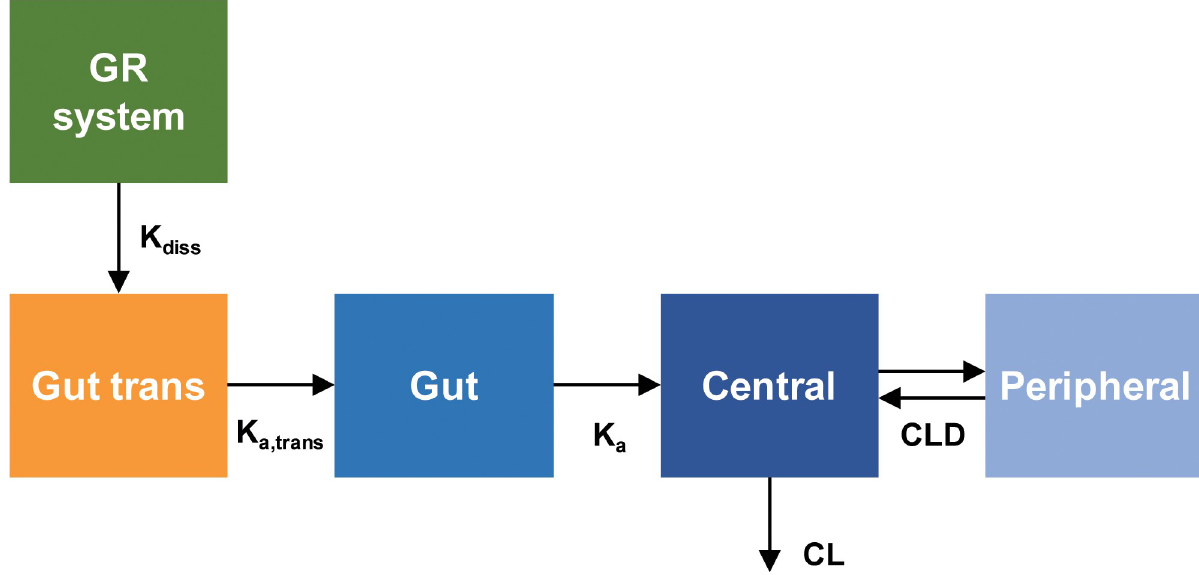
Fig 2. The pharmacokinetic model structure for the prediction of in vivo dissolution profile of acyclovir gastroretentive (GR) system. The population pharmacokinetic model of acyclovir to predict in vivo dissolution profile of GR system.